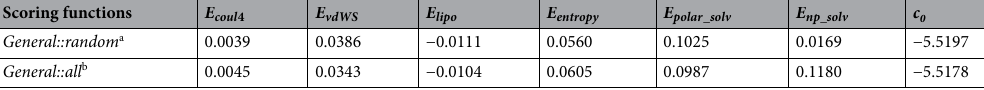
Table 2. Coefficients of the terms obtained for the general scoring functions trained with MLR. a Scoring function trained with the random training set (N = 2073). b Scoring function trained with the refined set minus core set (N =